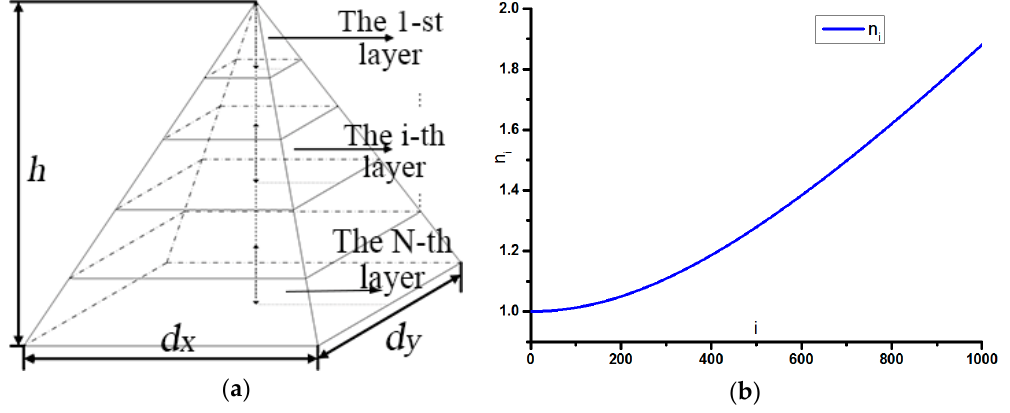
Figure 1. The modeling methods ( a ) and n i ( b ).